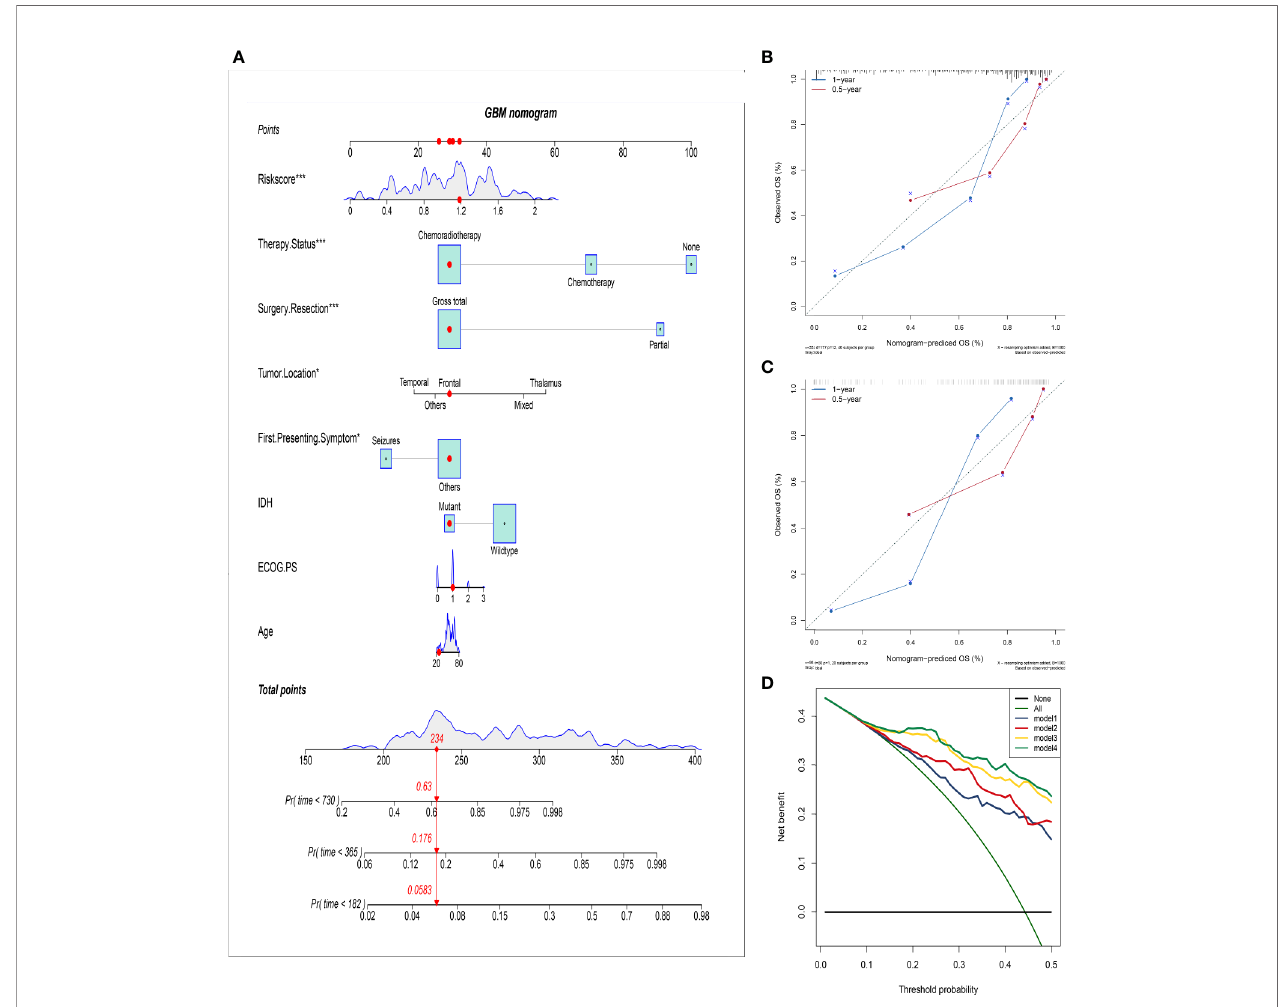
FIGURE 4 | Establish and validate an overall survival nomogram to predict a glioblastoma patient prognosis. (A) Nomogram to predict the probability of patient mortality based on HRS and clinical characteristics; (B) Calibration chart in the training group to verify the accuracy of the nomogram. Nomogram performance is shown by the plot, relative to the 40-degree line, which represents the ideal prediction; (C) Calibration chart in the external validation group to verify the accuracy of the nomogram; (D) Decision curve analysis of nomogram in the training group; model 1: preoperative clinical parameters; model 2: preoperative clinical parameters + HRS; model 3: preoperative and postoperative clinical parameters; model 4: preoperative and postoperative clinical parameters +